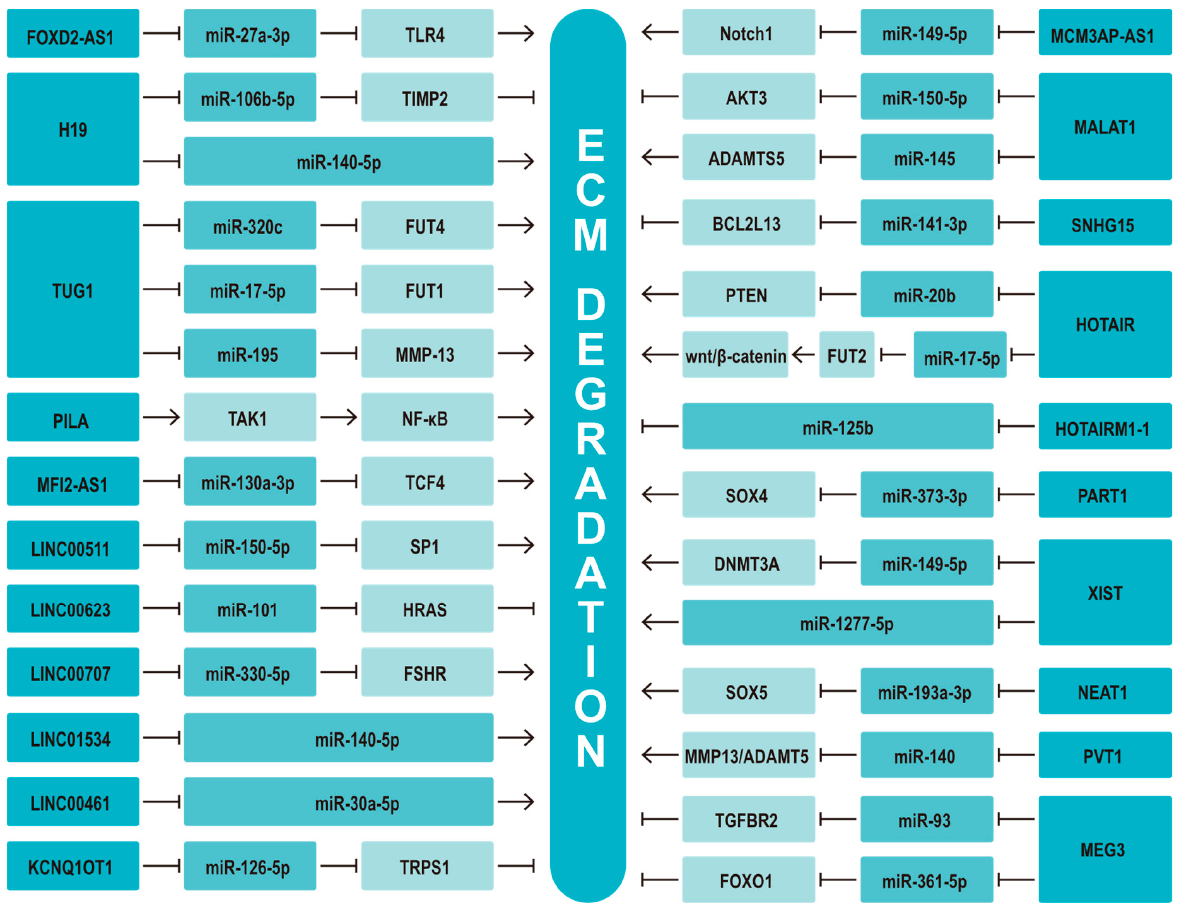
Figure 6. Schematic representation of the signaling pathways involved in this review for the regulation of ECM degradation by lncRNAs. Different shades of color represent different molecules.